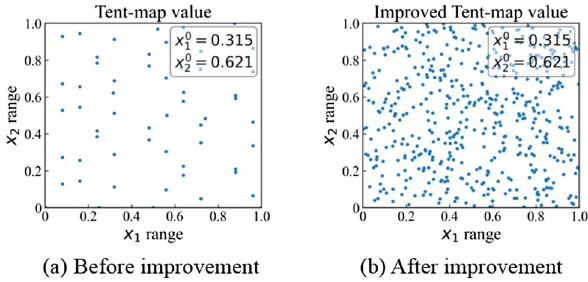
Fig. 2 Comparison of tent chaotic